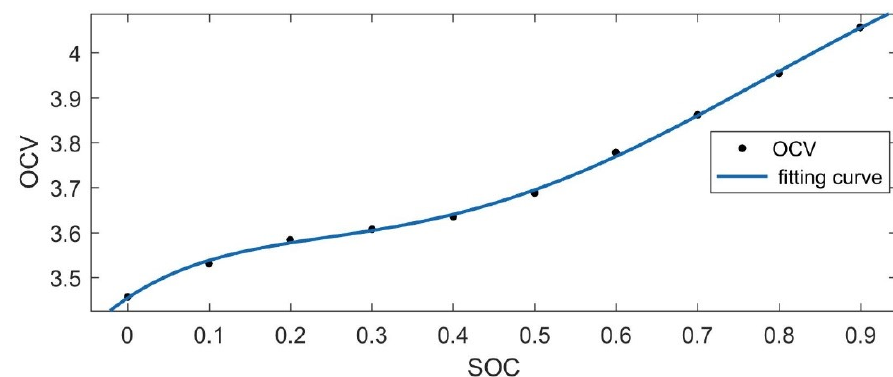
Figure 3. Test profile of the incremental OCV test.